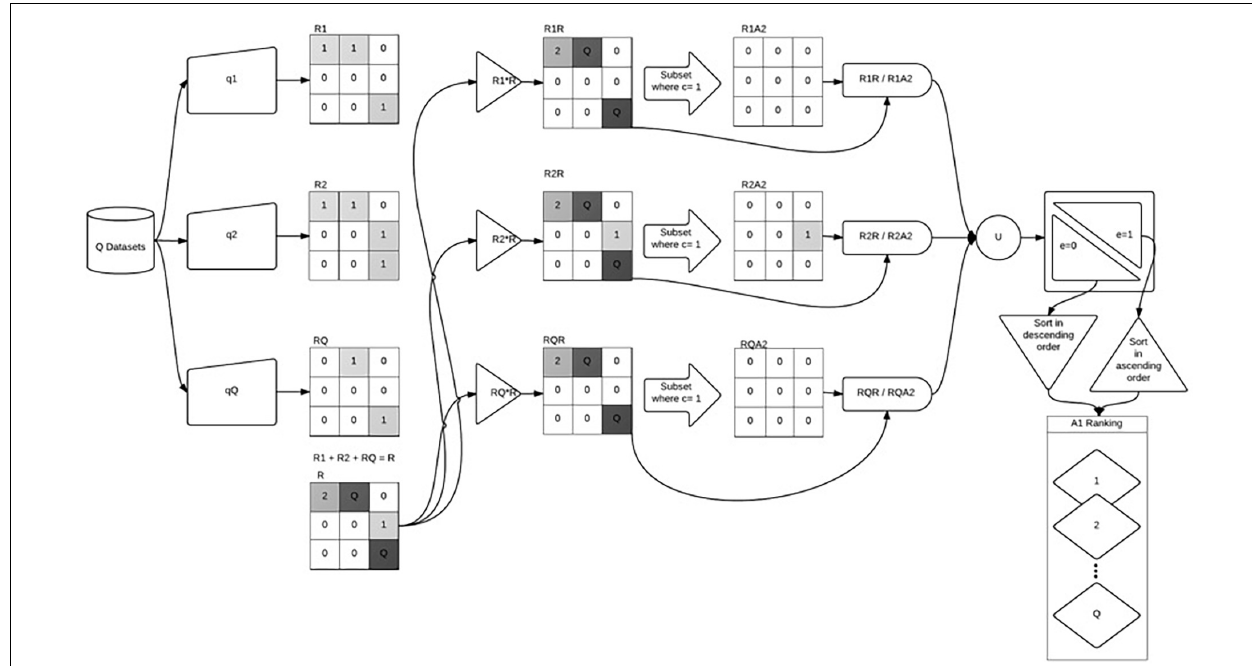
FIGURE 3 | Aptness (A1) component, adapted from Shimizu (2014).